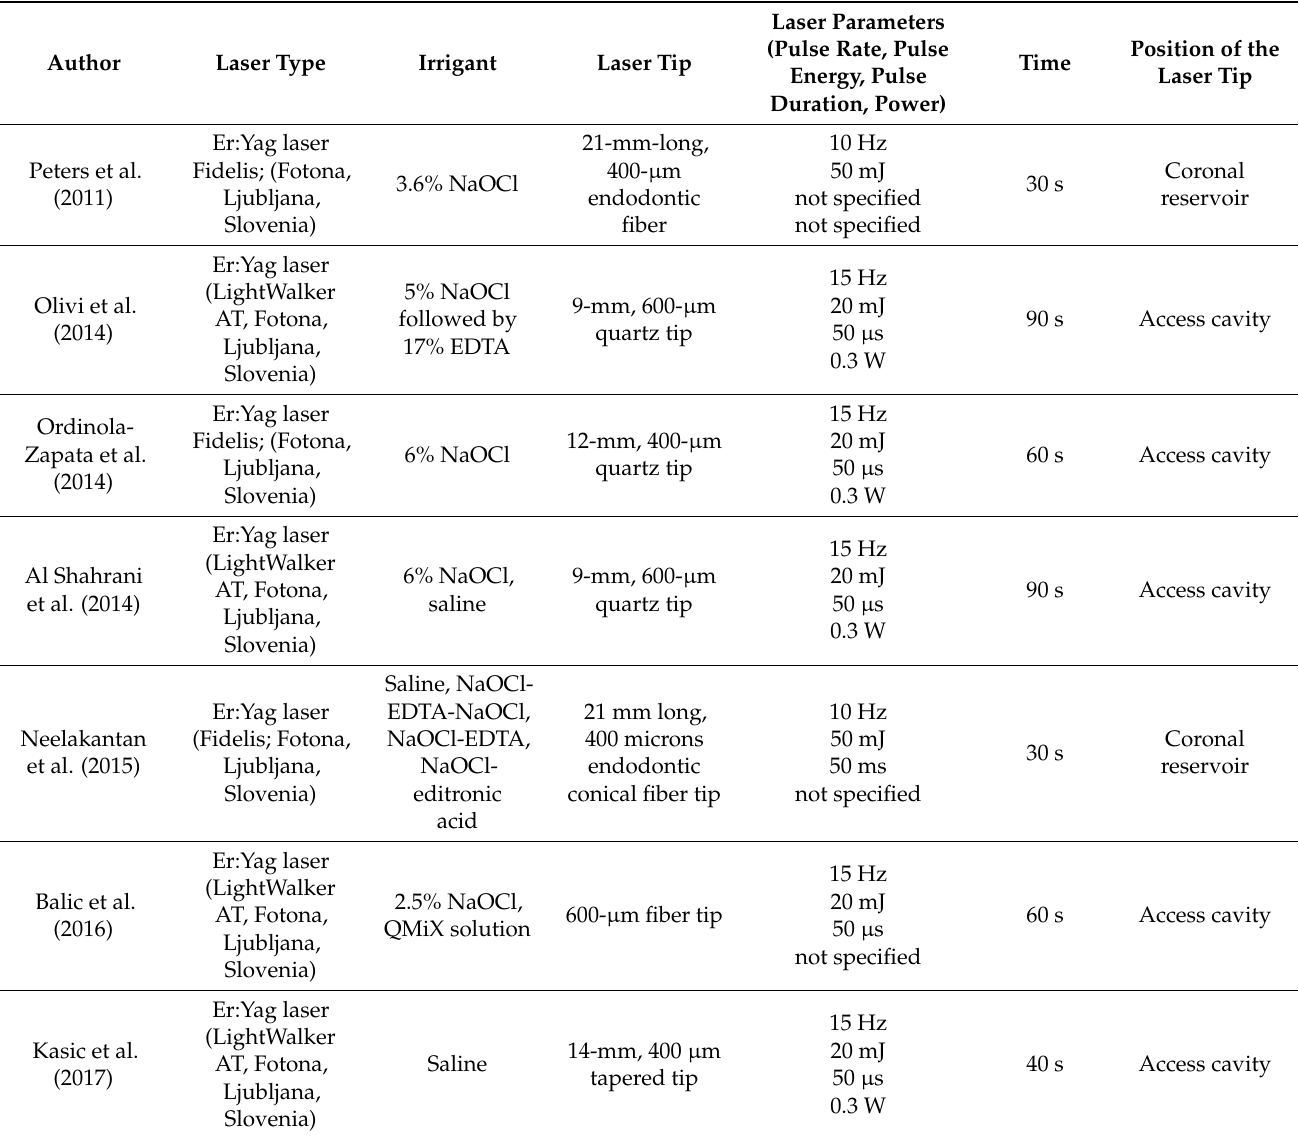
Table 5. Details on laser type, irrigant, laser tip design and parameters, time of irradiation and position of the tip used during